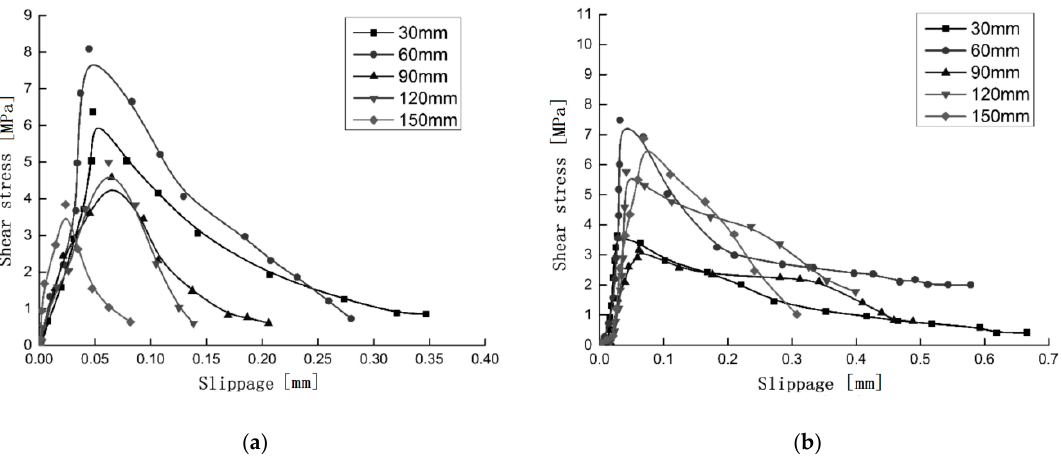
Figure 4. Interfacial stress-slip curves of specimens ( a ) A-3-1 and ( b ) B-1-2.